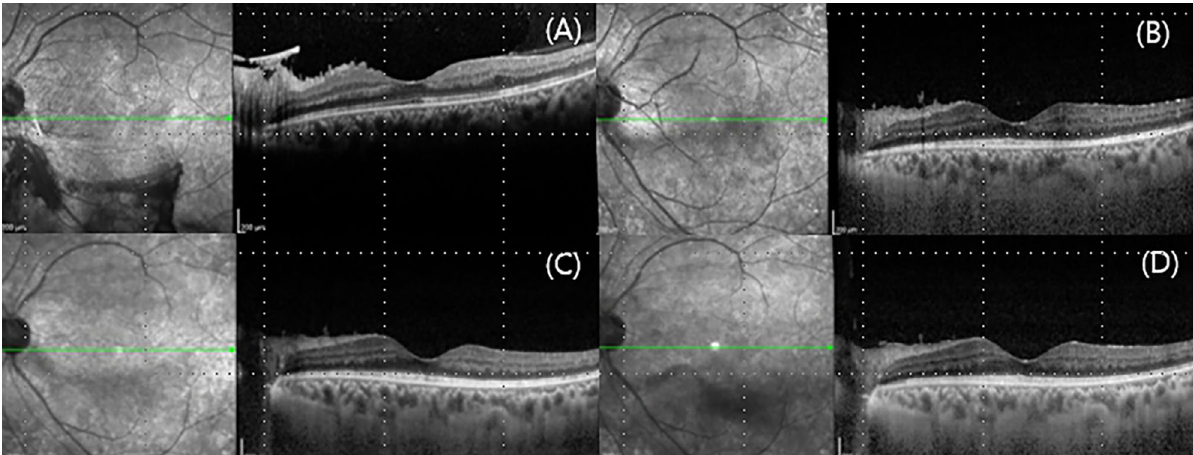
Figure 4. Optical coherence tomography of case 1 at ( A ) initial visit, ( B ) 24 months, ( C ) 48 months, and final visit. No diabetic macular edema developed during the follow-up